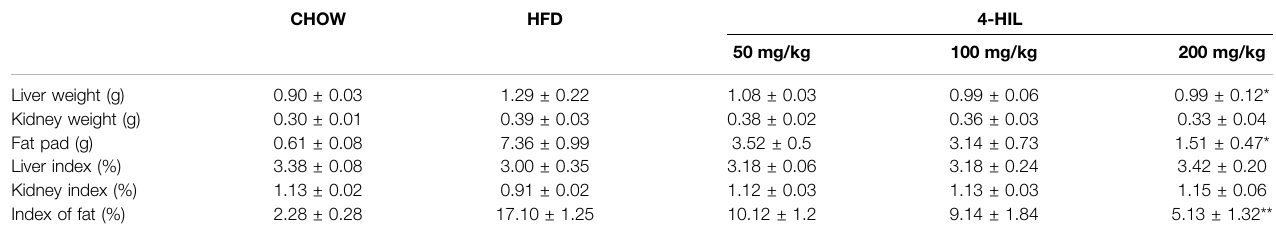
TABLE 1 | Body and organ weights at the end of treatment.